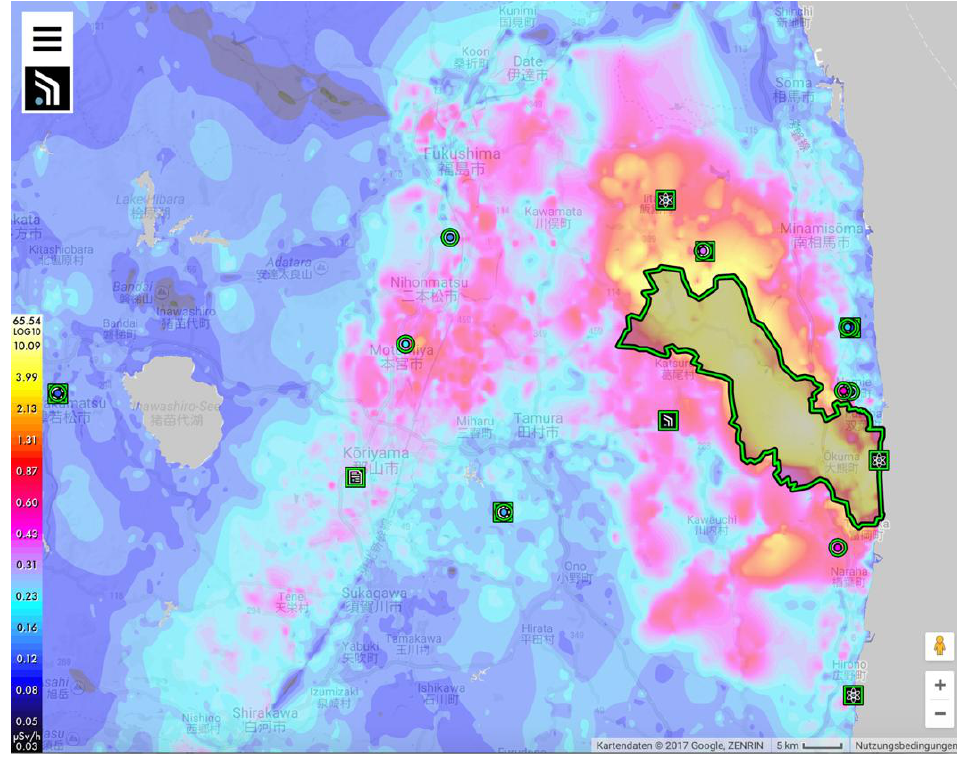
Figure 6. Local dose rates according to Safecast measurements on 7 March 2017 (in µSv/h) [88].